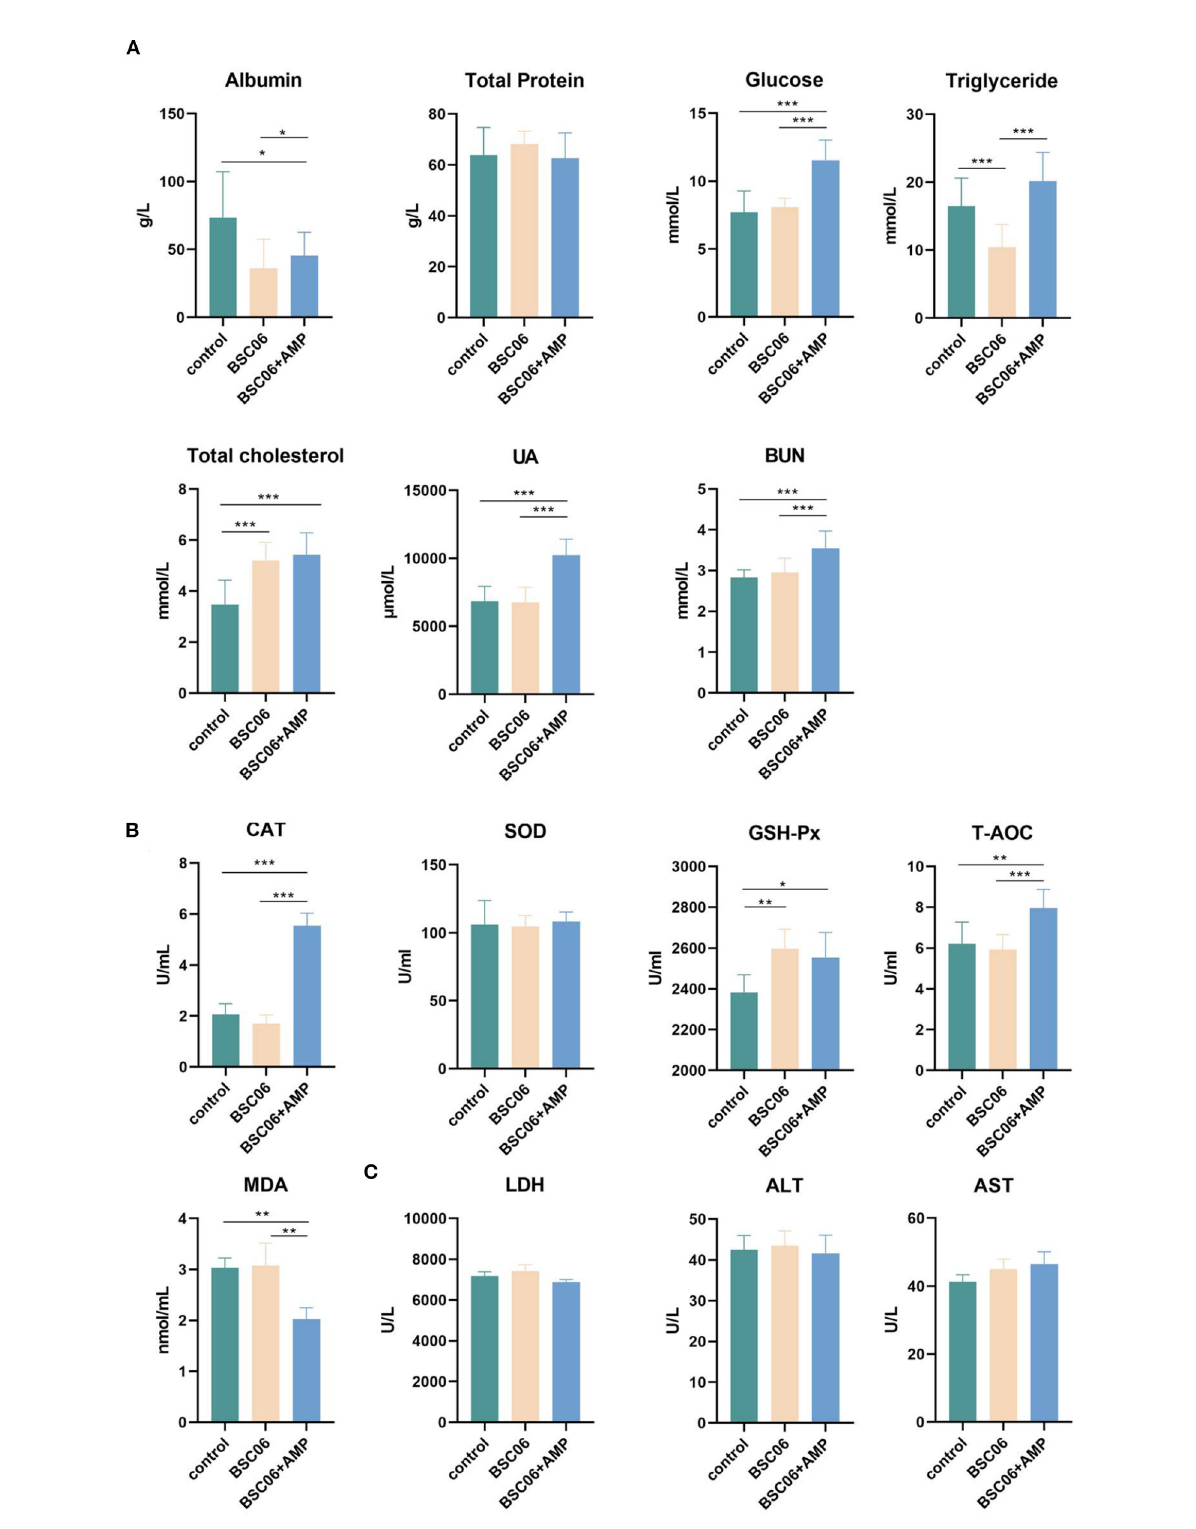
FIGURE2 Blood biochemical parameters of laying hens. (A) Nutrition-related biochemical parameters. (B) Measurement of related indexes of antioxidant levels in serum. (C) Content of LDH, ALT and AST level in serum ( n = 6). Data are presented as the means ± SD for n = 12; * P < 0.05, ** P < 0.01, *** P <